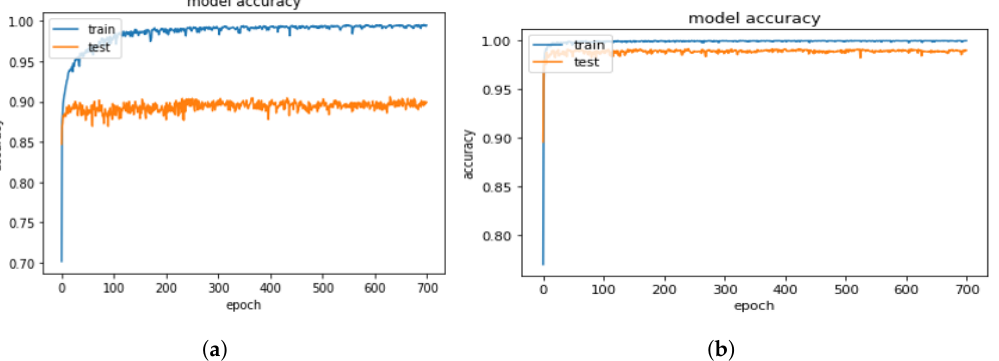
Figure 7. Comparison between history models Accuracy for 11,814 samples and 18,526 samples. ( a ) Accuracy for 11,814 samples. ( b ) Accuracy for 18,526.